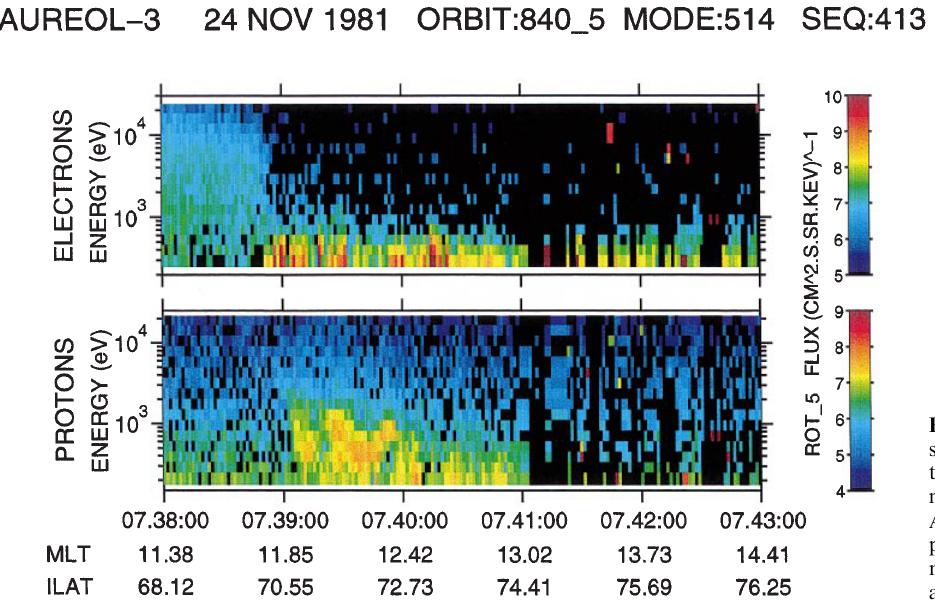
Fig. 1. Colour-coded energy-time spectrograms for 0.2–22 keV elec- trons and protons (ROBE instru- ment, sensors ROT_E5/P5) for the AUREOL-3 cusp pass (840 North), plotted as a function of UT, mag- netic local time (MLT) and invari- ant latitude (ILAT)